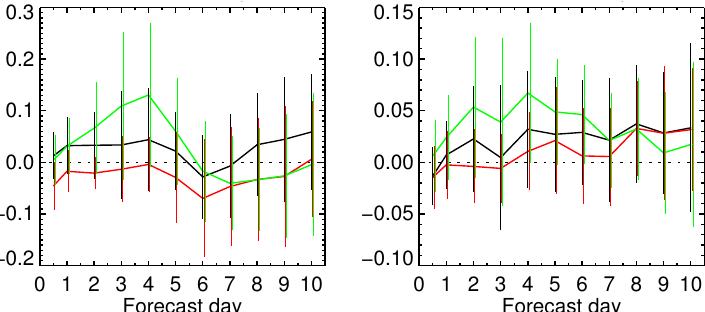
Figure 11. The same as Figure 9 but for the Group III of experiments; red curve is for SMOS+Btext experiment, black curve for SMOS+Bprop experiment and green curve is for SMOS+3DB , all compared to the control SMOS